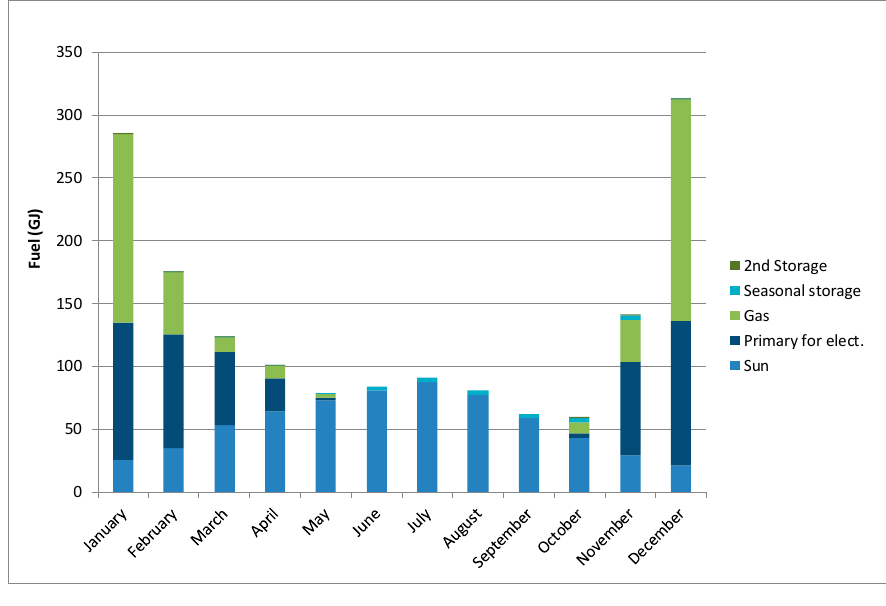
Figure 5. Complete system: